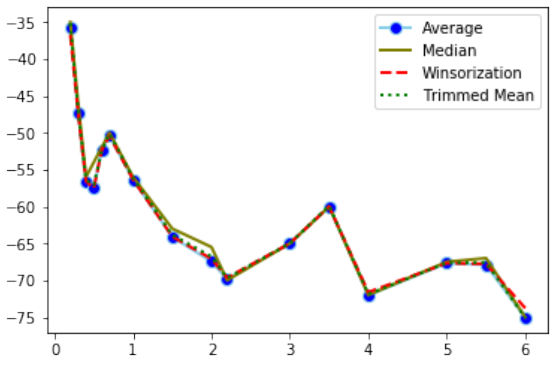
Figure 4. Filtered RSSI recordings using Band 2 in the office.